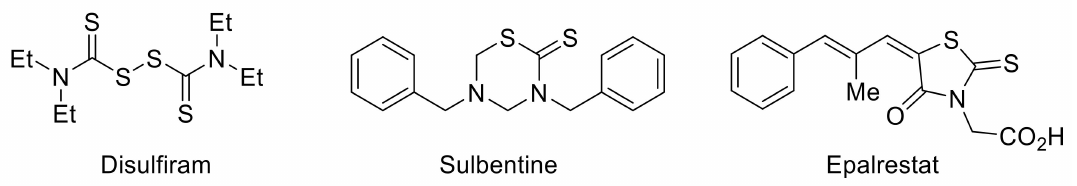
Figure 2. Structures of dithiocarbamate based